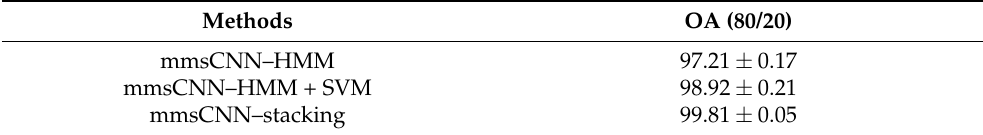
Table 3. XGBoost ablation experiments on UCM dataset.